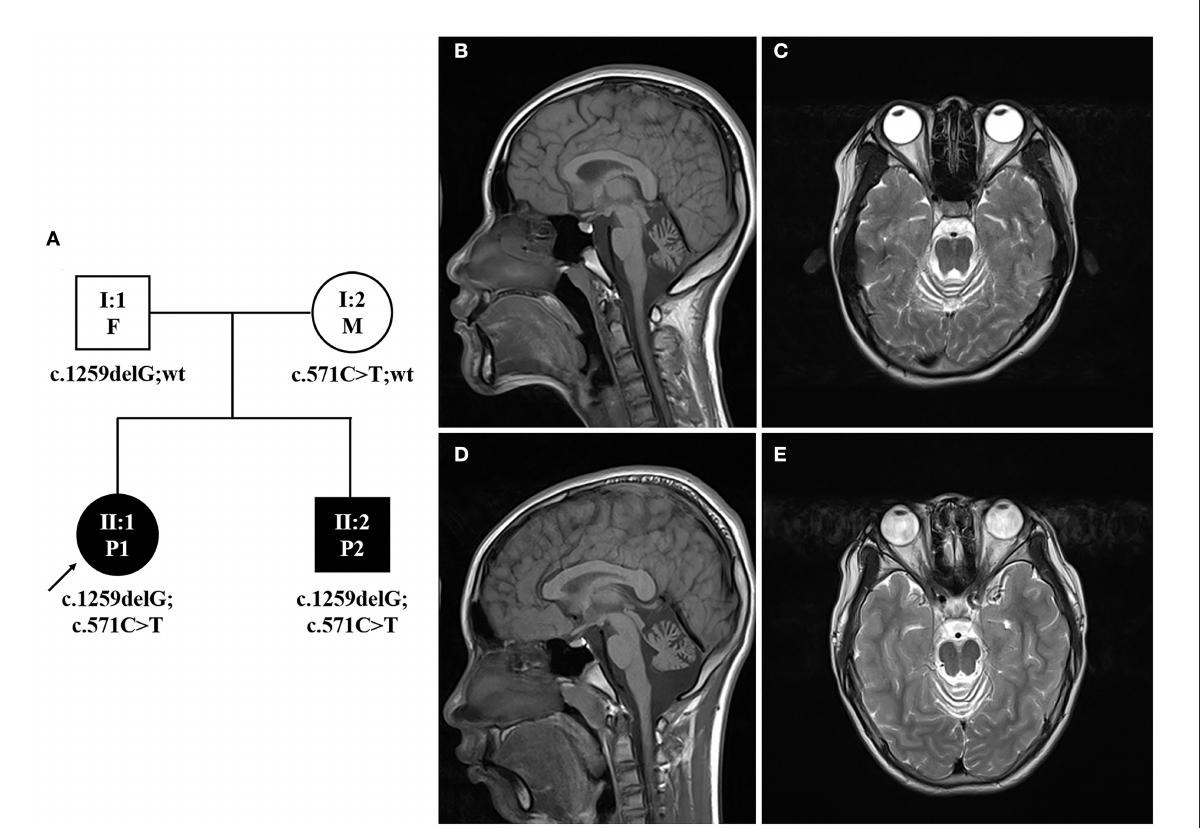
FIGURE1 Pedigree and brain MRI of the proband. (A) Pedigree of the family with identified MSTO1 variants. Open symbols, unaffected; filled symbols, affected; squares, male; circles, female; arrow, the proband; F, father; M, mother; P1, patient 1; P2, patient 2. (B,C) Brain MRIs of the proband (II:1, P1) showed atrophy of the cerebellum and brain stem, predominantly at the cerebellum. (D,E) Brain MRIs of the younger brother of the proband (II:2, P2) showed predominant cerebellar atrophy.